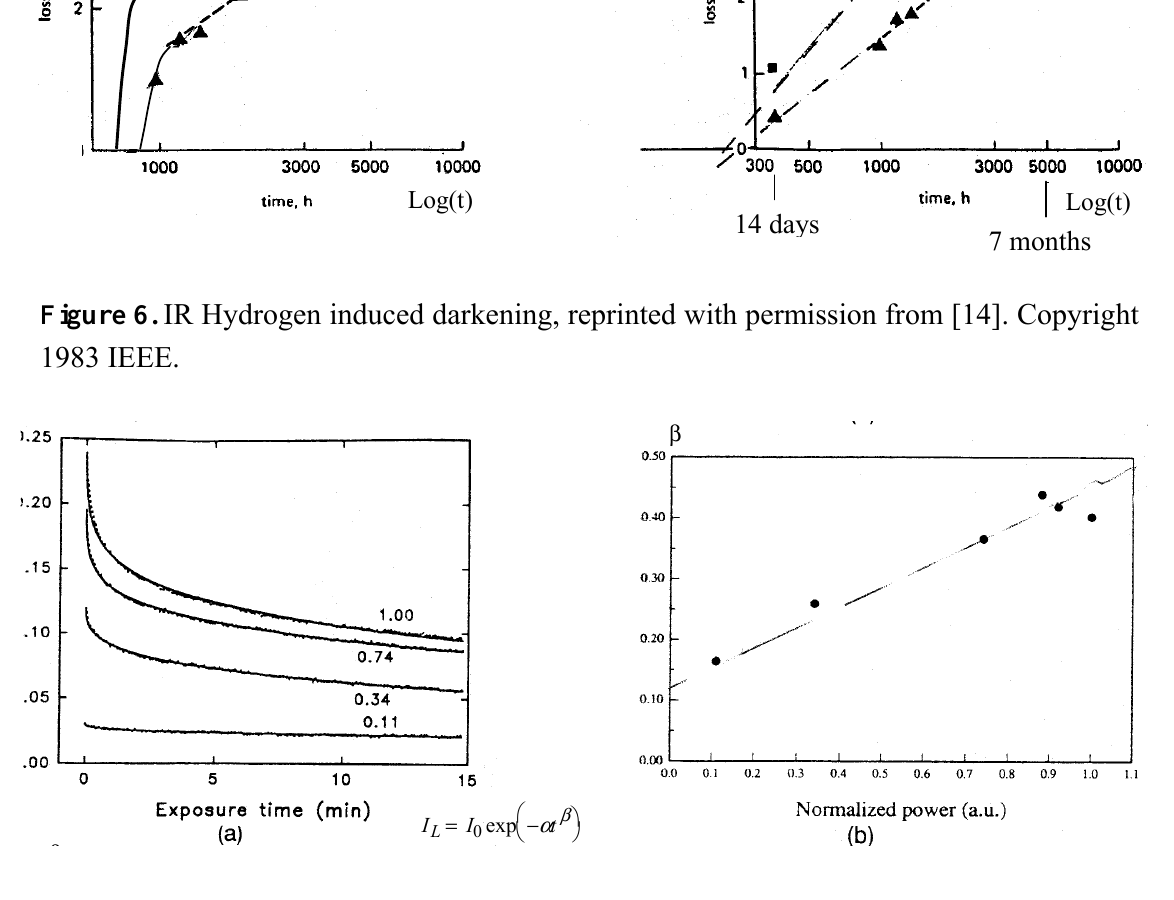
Figure 7. ( a ) Bleaching of 400 nm luminescence by 266 nm light in Ge-doped SiO 2 fibers, reprinted with permission from [16]. Copyright 1993 OSA; ( b ) Exponent β of the stretched exponential law according to the power